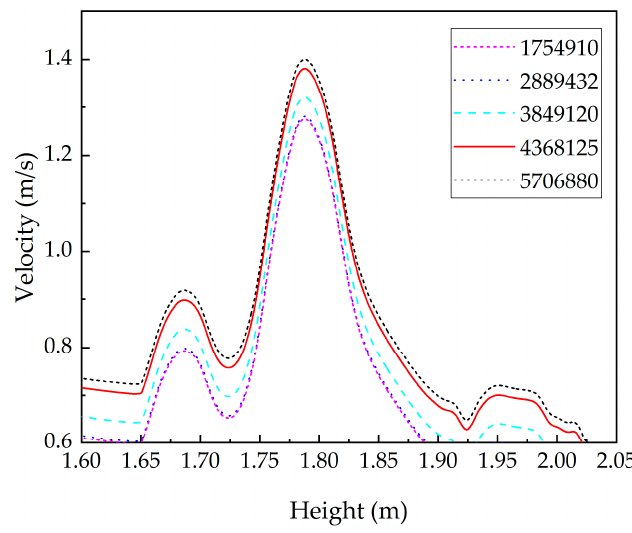
Figure 5. Mesh independence verification.